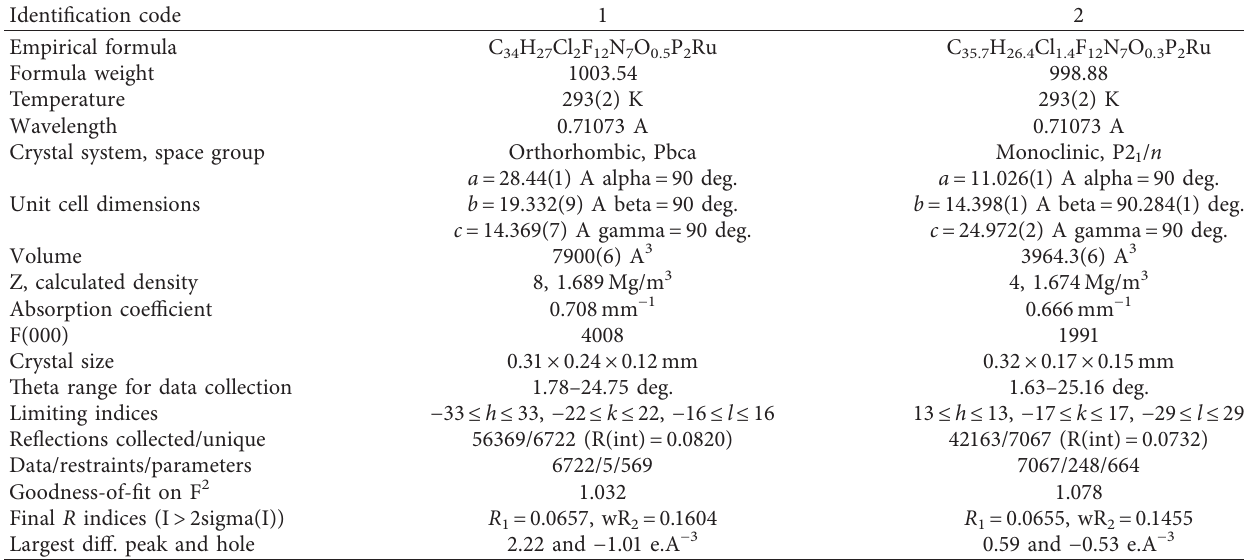
Table 1: Crystal data and structure refinement for 1 and